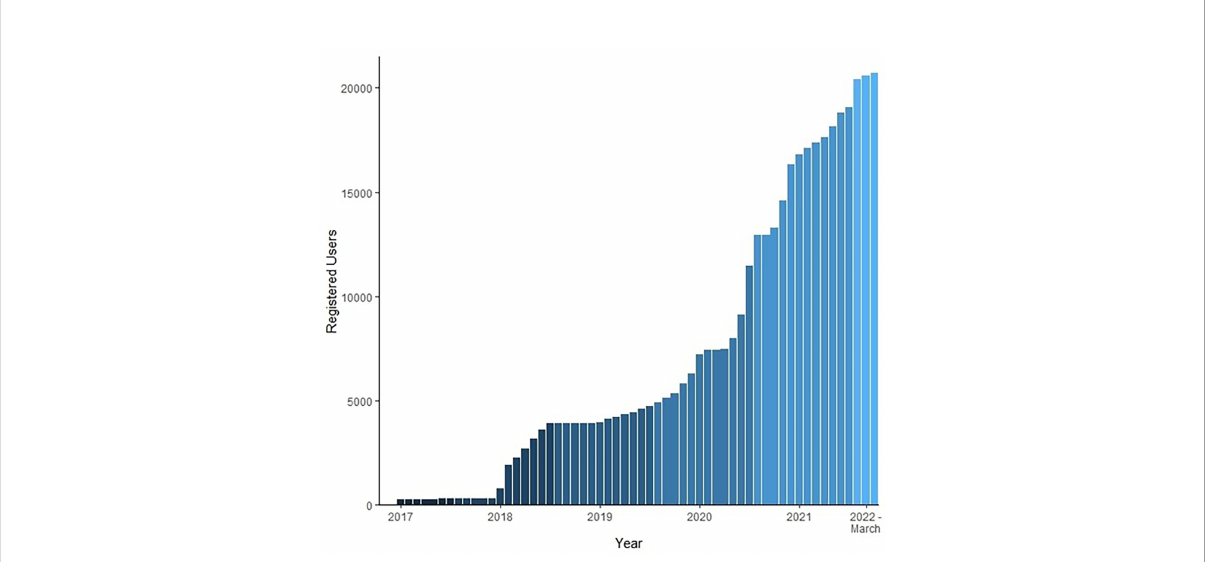
FIGURE 5 Total registered users contributing to Beluga Bits since the project ’ s inception. Bars represent cumulative users per month per year. Beluga Bits project of fi cially launched on Zooniverse in April,